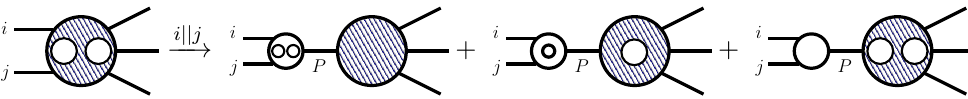
Figure 3. Graphical representation of equation (B.5). White blobs represent the splitting am- plitudes and hatched blobs represent the four-point amplitudes. The number of contained circles represents the loop order of the object. The types of particles are omitted from this representation, the external and internal lines representing only